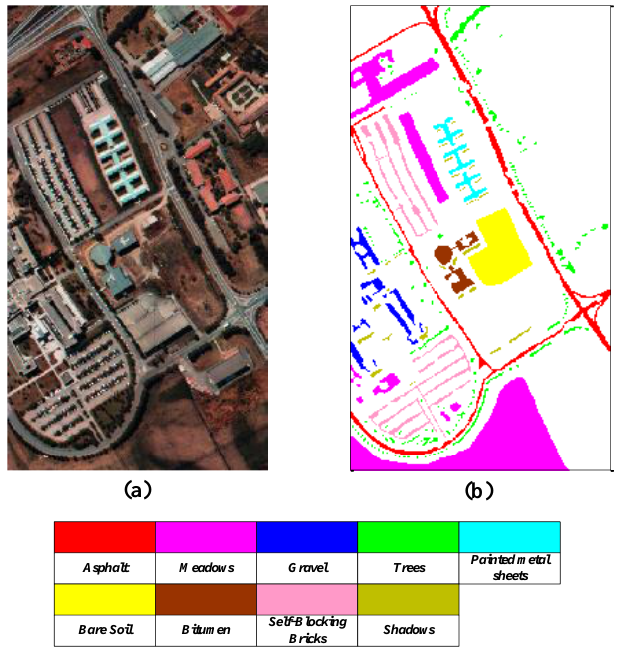
Figure 6. The Pavia University scene: ( a ) false‑color image and ( b ) ground truth map. The last land cover hyperspectral scene is Salinas. This land cover scene was acquired by the AVIRIS sensor over Salinas Valley, California. The scene image contains 512 × 217 pixels with a spatial resolution of 3.7 m and provides 204 spectral bands after discarding the 20 water absorption bands. Its false-color image is shown in Figure 7a, and its ground truth map is shown in Figure 7b composed of 16 land cover classes.